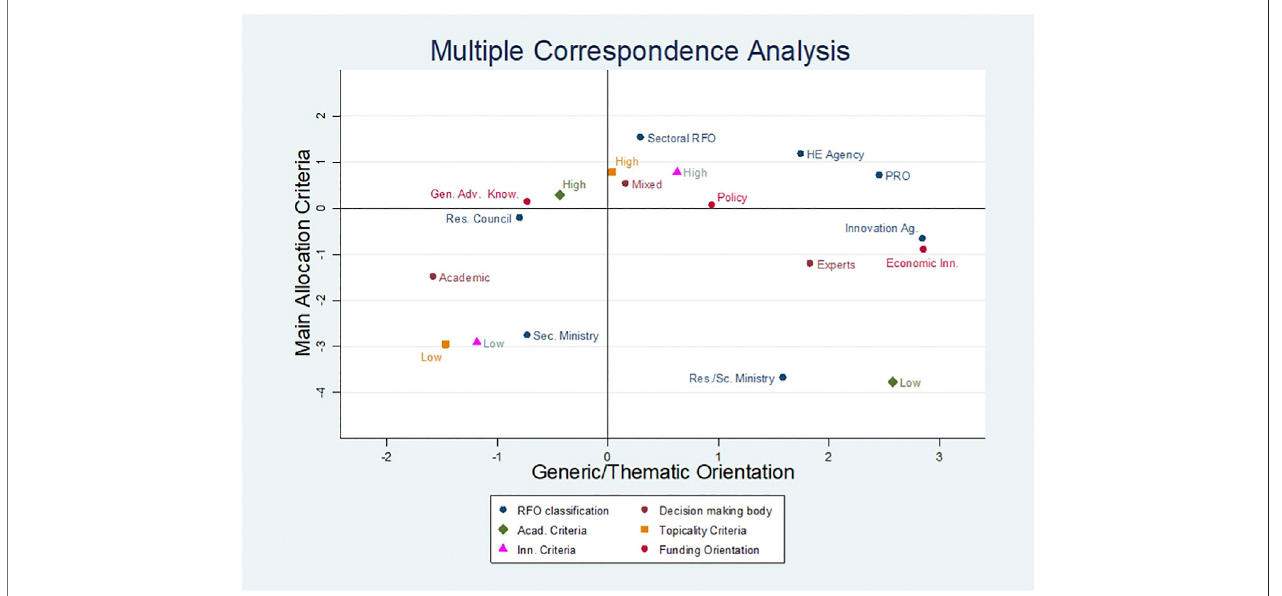
FIGURE 3 | MCA coordinate